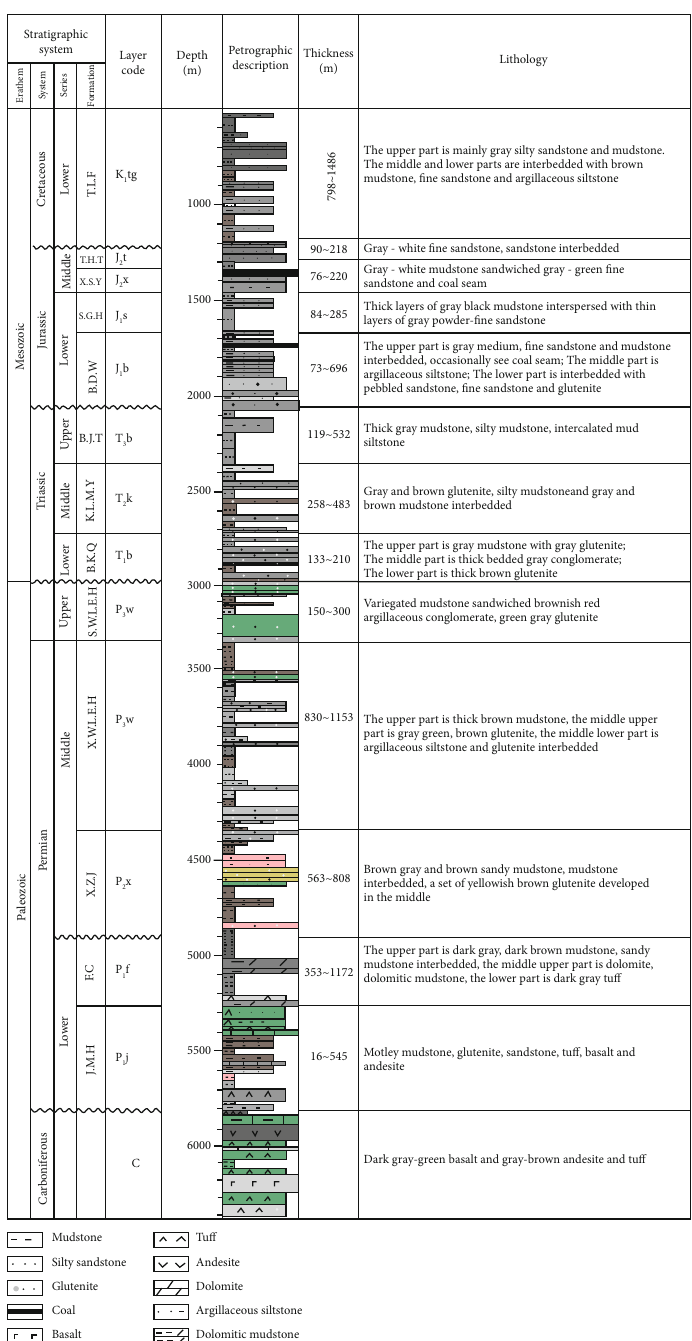
Figure 2: Comprehensive stratigraphic column of the Mahu